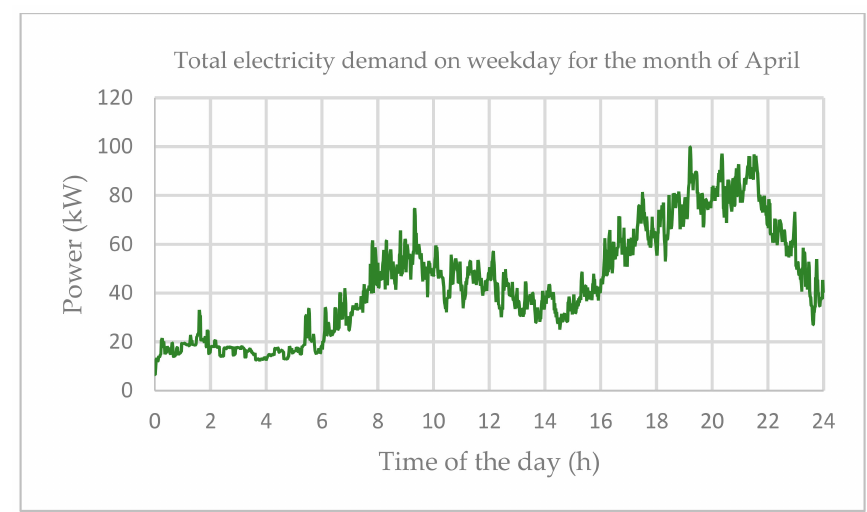
Figure 5. Load profile 1 for the month of April over 24